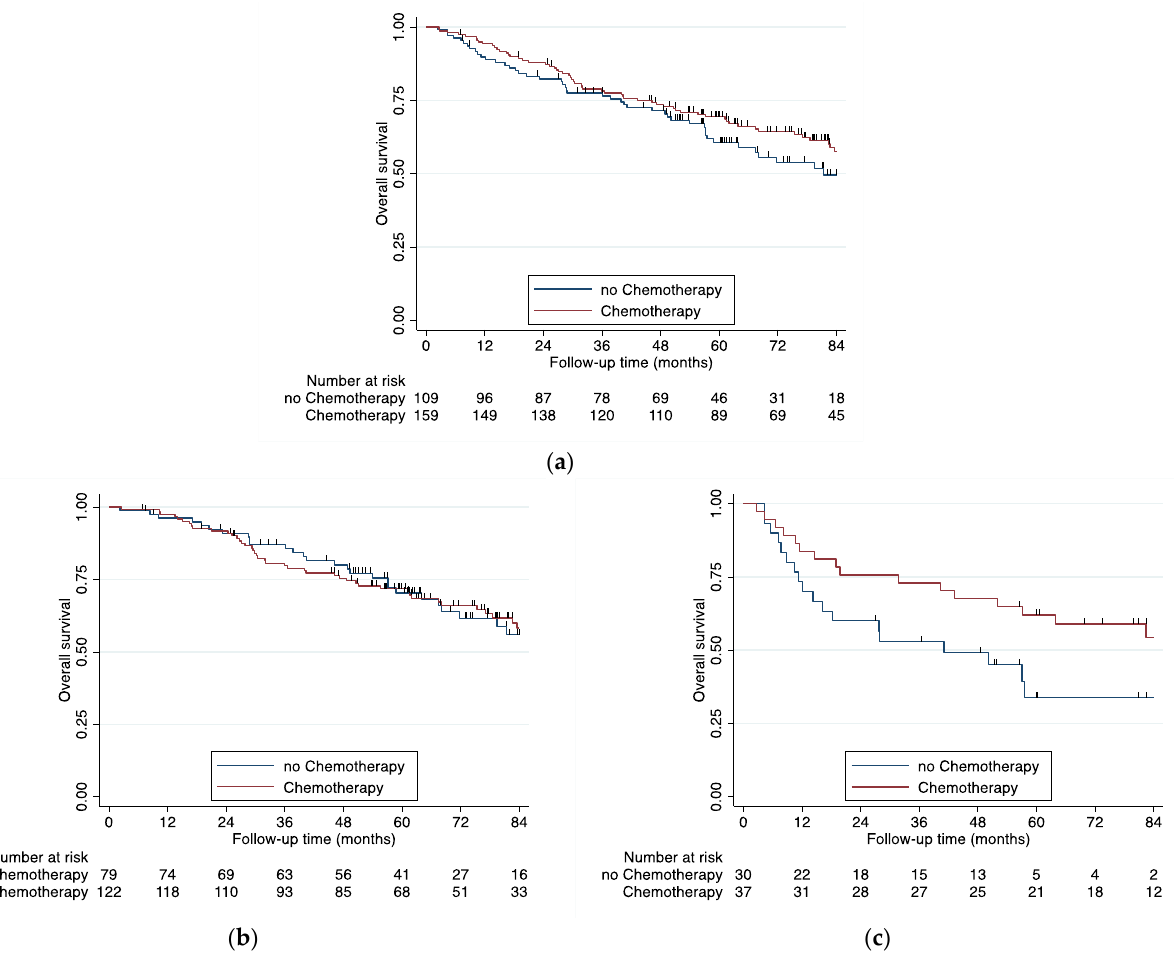
Figure 2. Benefit of adjuvant chemotherapy. Patients with adjuvant radio–chemotherapy/radiotherapy are excluded. ( a ) All patients, logrank test p = 0.2207 ( b ) tumor larger than 7cm and second or multiple nodules in the same lobe (T3a), logrank test p = 0.9880 ( c ) Parietal pleural invasion and the mixed subtype (T3b), logrank test p = 0.0261.